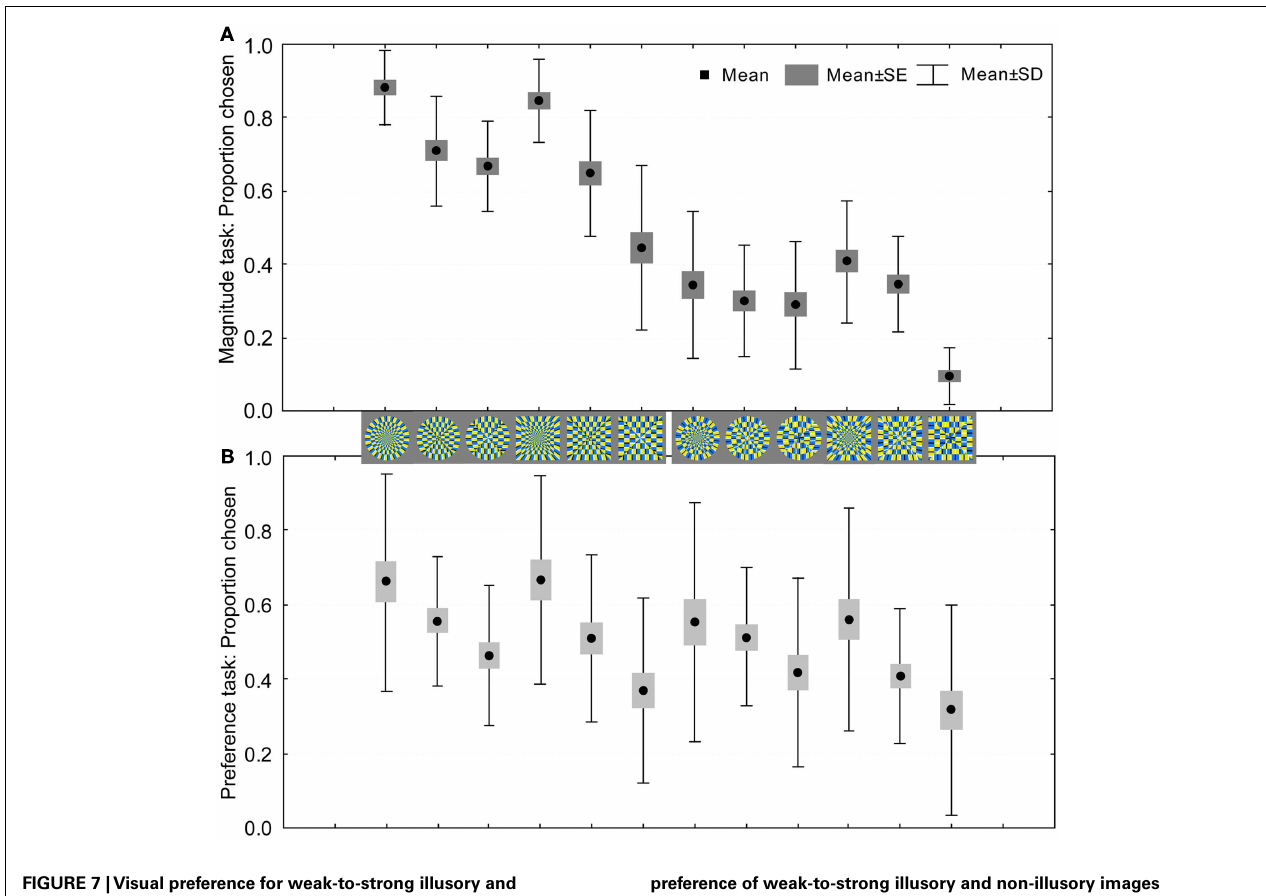
FIGURE 7 |Visual preference for weak-to-strong illusory and non-illusory images: average proportion by which the image was chosen among others as a function of illusion magnitude (A); visual